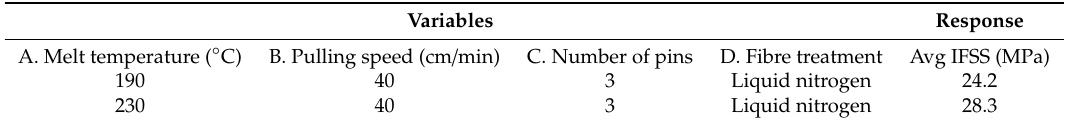
Figure 17. Cube of IFSS prediction at (A) the minimum temperature and (B) the maximum temperature. Table 7. Results of the confirmation